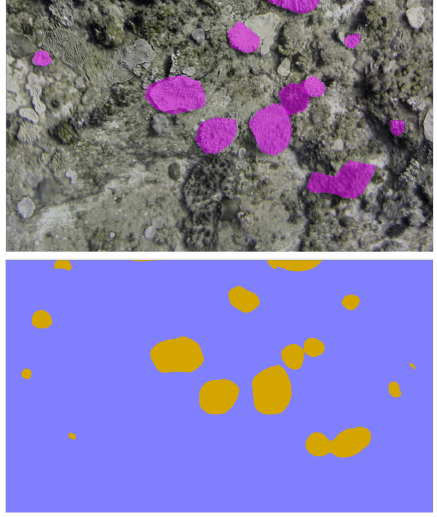
Figure 9. (Above) A close-up of the polygon labeled ortho-mosaic. (Below) The corresponding semantic segmentation obtained by our network on the Test